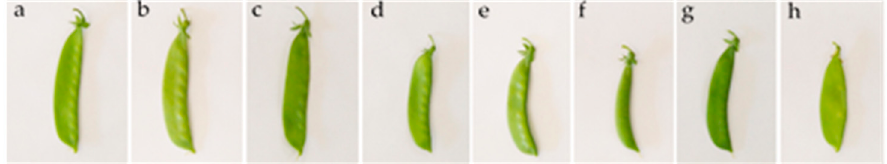
Figure 1. Pea pods of the different cultivars of mangetout analyzed. From left to right: Local landrace ( a ), AR-24007 ( b ), Capuchino ( c ), Tirabeque IS ( d ), Tirabí ( e ), Pea Zuccola ( f ), Pea Delikata ( g ) and Bamby ( h ). Table 1. Cultivars, companies and growth habit of mangetout used in this study.